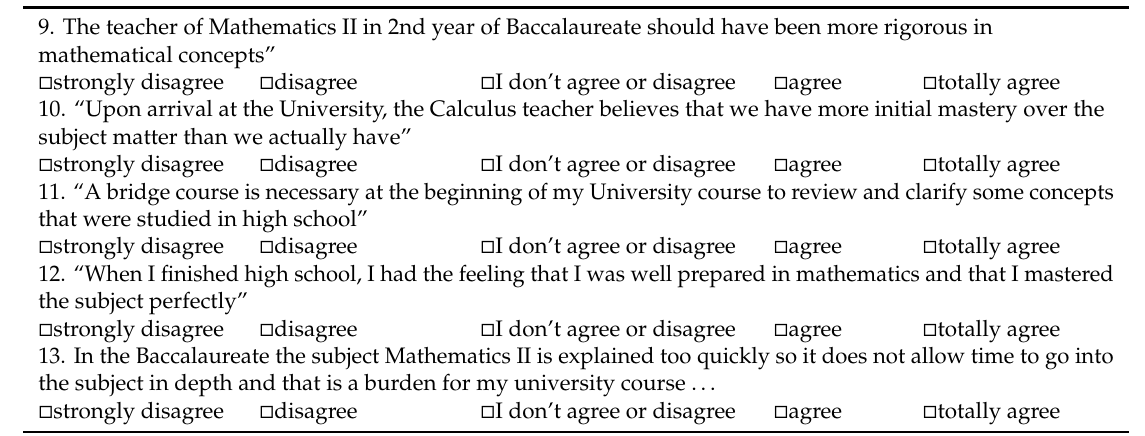
Table 3. Survey of student’s perception of their own level and of the subject. Part II. Phrase